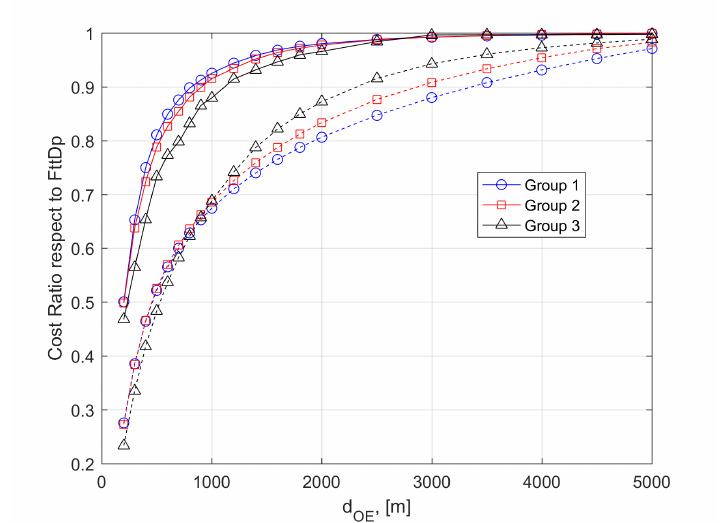
Figure 10. Cost for the evolved FttC network. Two evolution options: new Cabinets installed at d OE (first option, dashed lines), new Cabinets installed at the distance of the first distributor at distance greater or equal to d OE (second option, solid